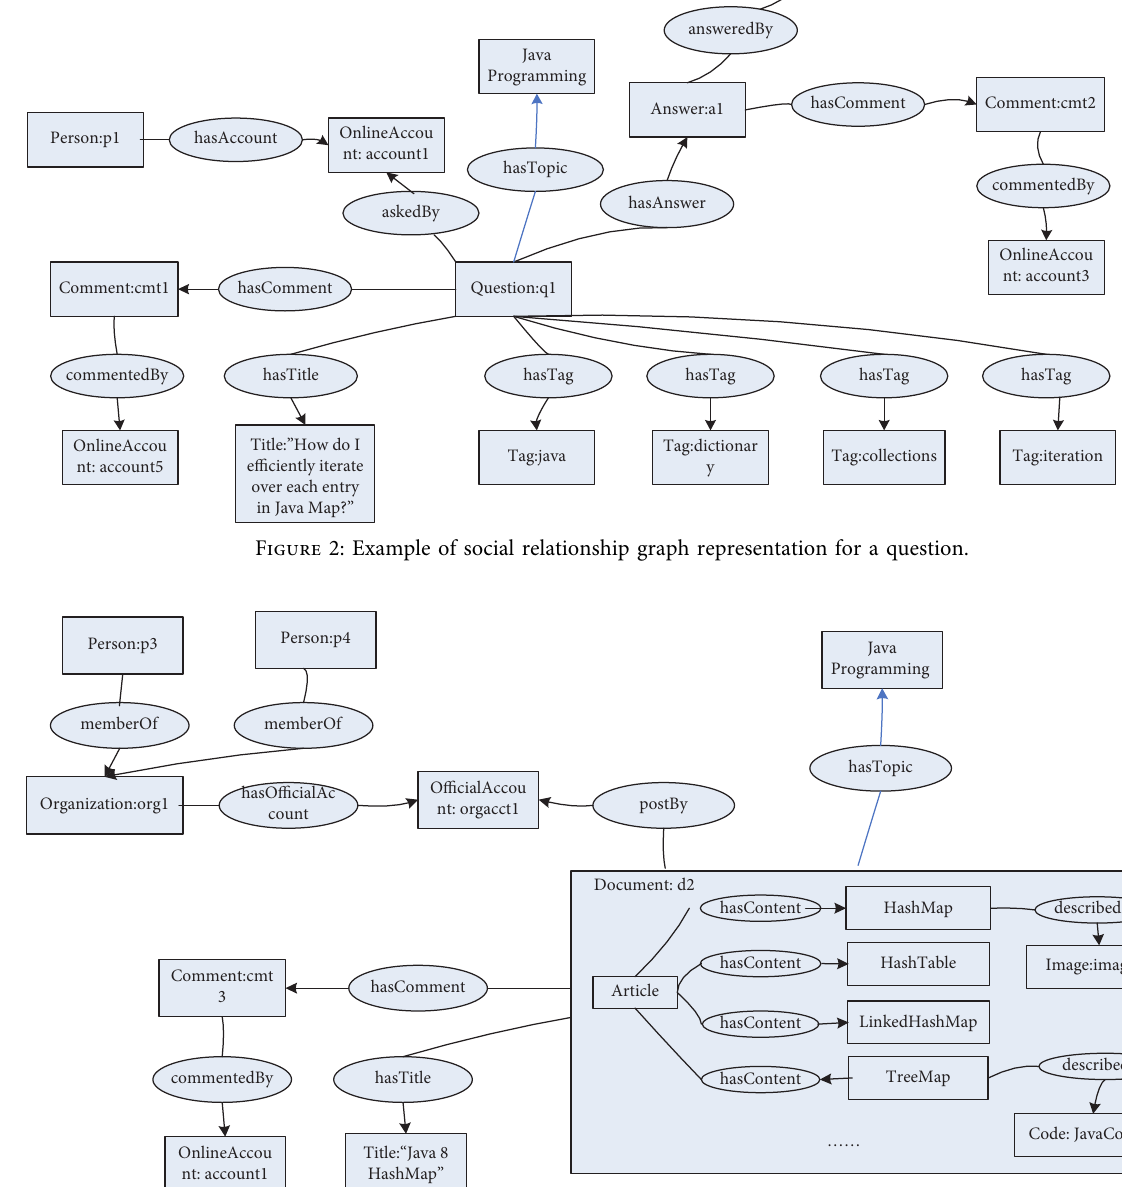
Figure 3: Example of social relationship graph representation for a